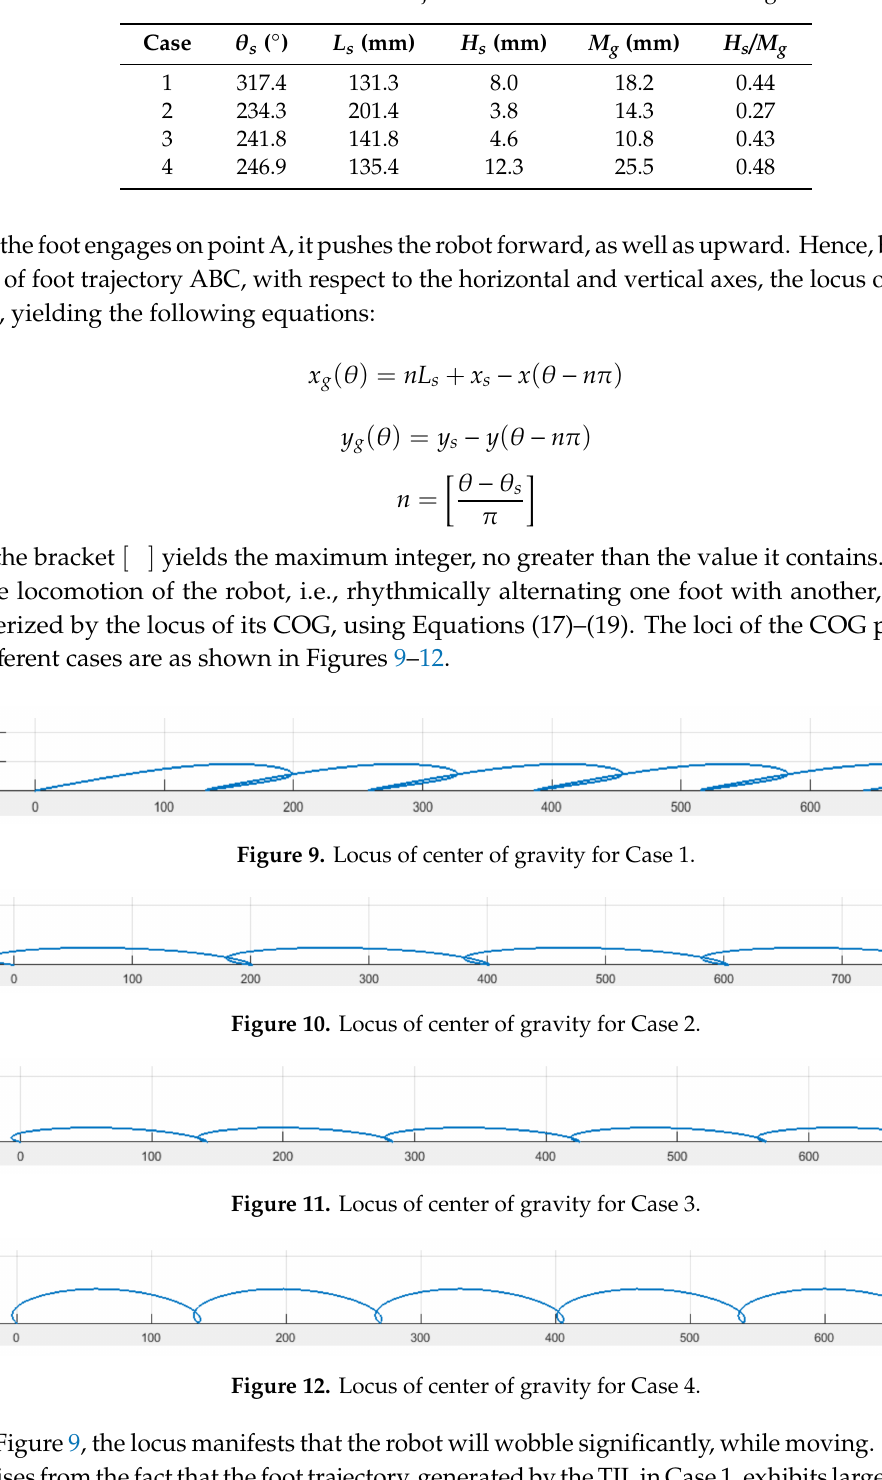
Table 2. Characteristics of foot trajectories related to four sets of design data.